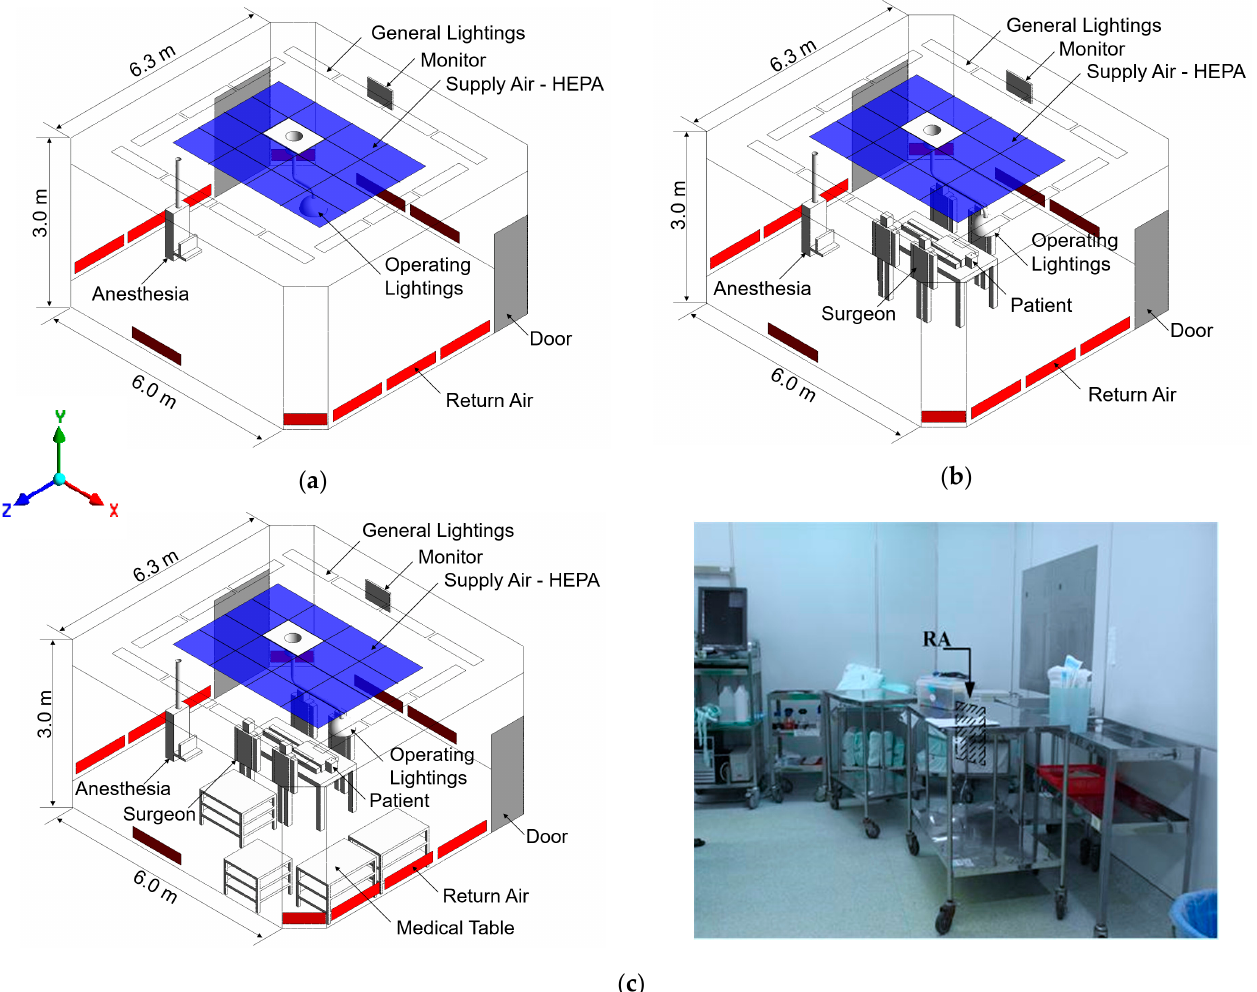
Figure 3. The geometry of the investigated operating room in three different schemes: ( a ) case 1: at-rest condition; ( b ) case 2: operational condition; ( c ) case 3: actual condition.